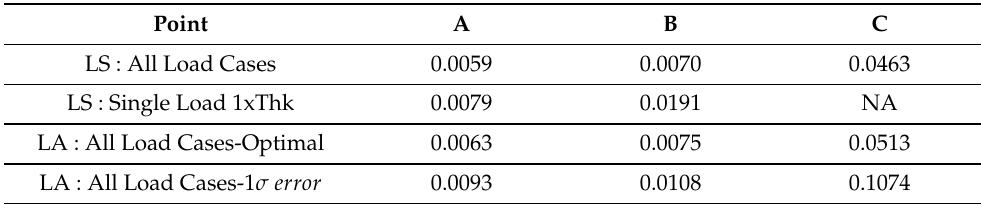
Table 1. Periodicity values, (cid:101) as defined in Equation (19), for the NNM solutions presented in subplot (b) of Figure